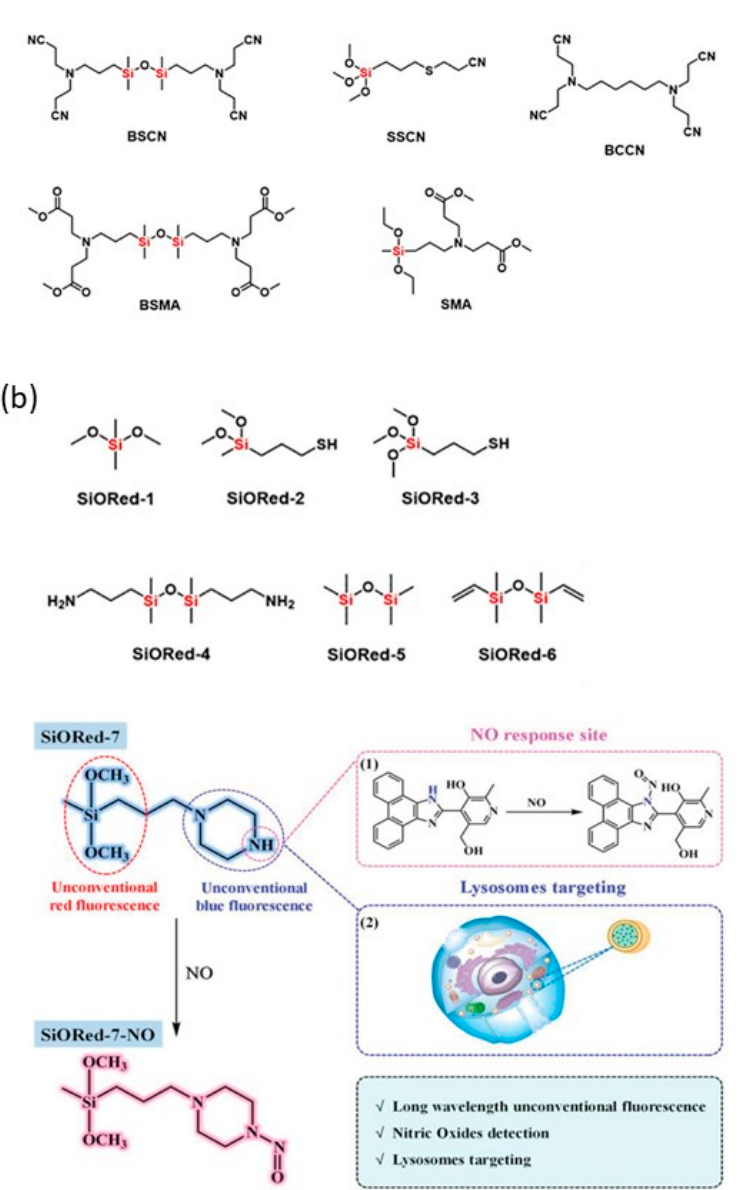
Figure 5. ( a ) Siloxane-based unconventional fluorescent compounds [40], Copyright 2017, Wiley pub- lishing. ( b ) Structures of SiORed-1~SiORed-6 and the detection of NO by SiORed-7 [38],